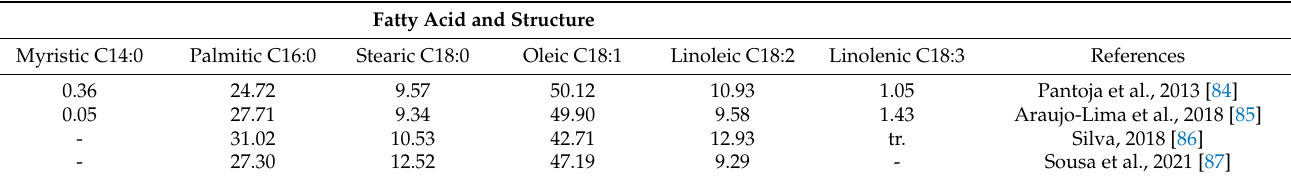
Table 1. Main fatty acids (%) in andiroba oil. Fatty Acid and Structure